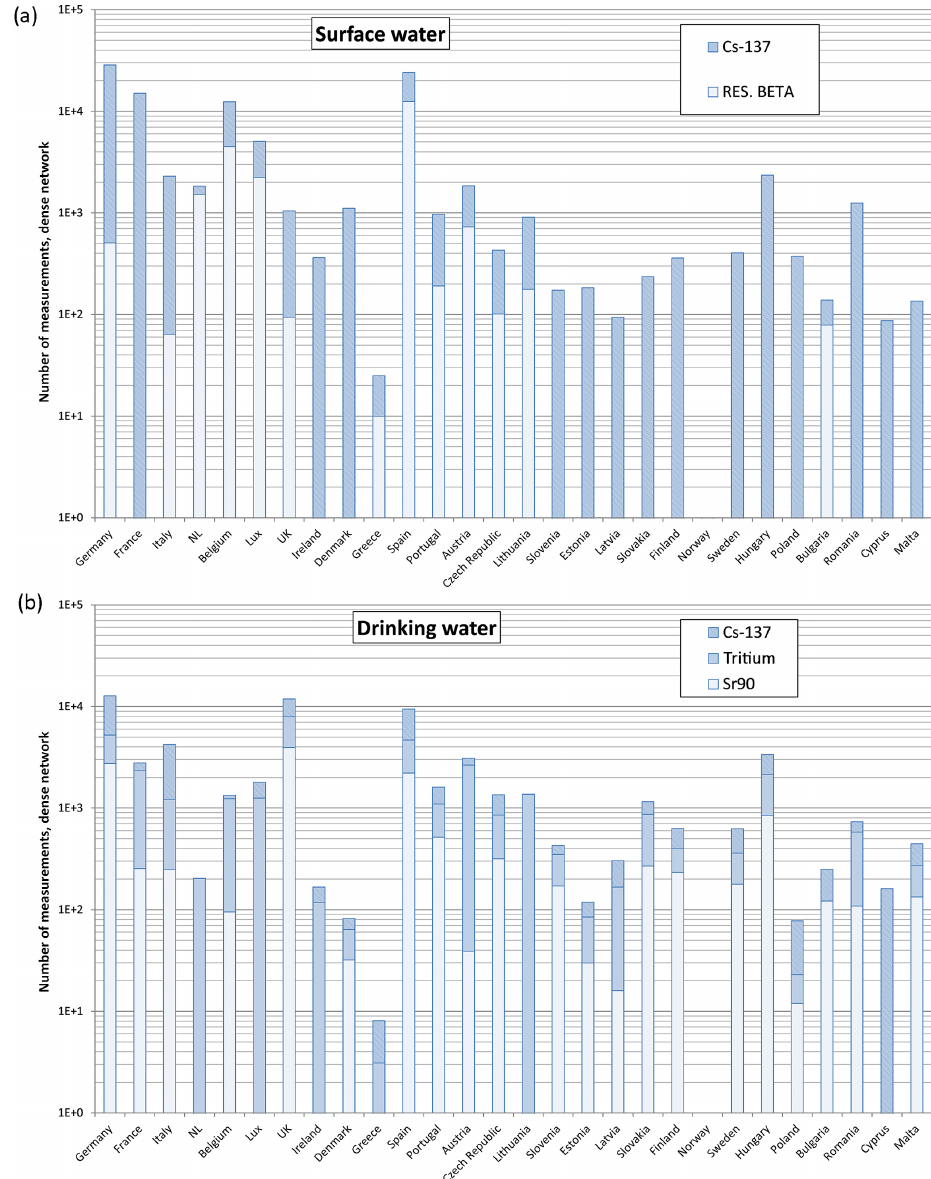
Figure 9. (a) Number of measurements in REMdb (dense network) for surface water, by country, as recommended in 2000/473/Eu- ratom (2000). (b) Number of measurements in REMdb (dense network) for drinking water, by country, as recommended in 2000/473/Eu- ratom